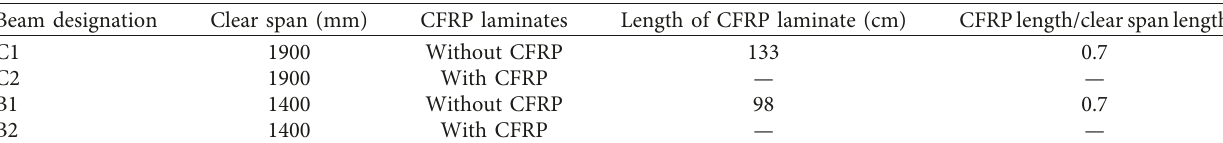
Figure 3: Description details of tested steel beams. Table 5: Description of the tested steel